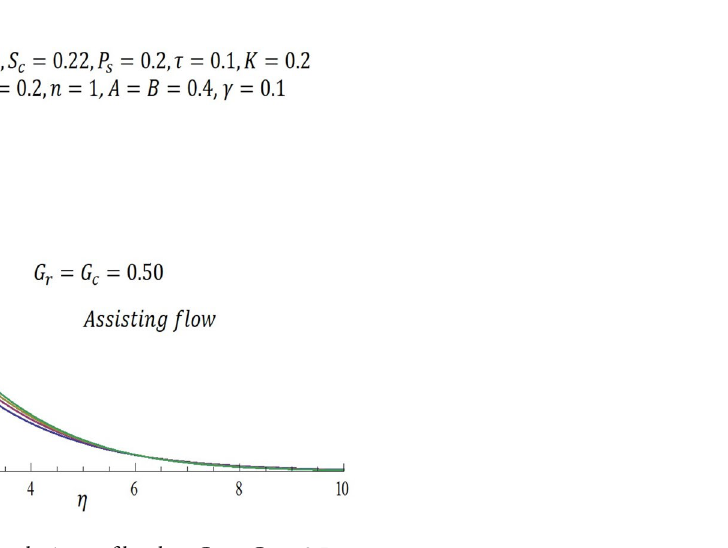
Figure 11. Effect of ω on velocity profile when G r = G c = 0.5